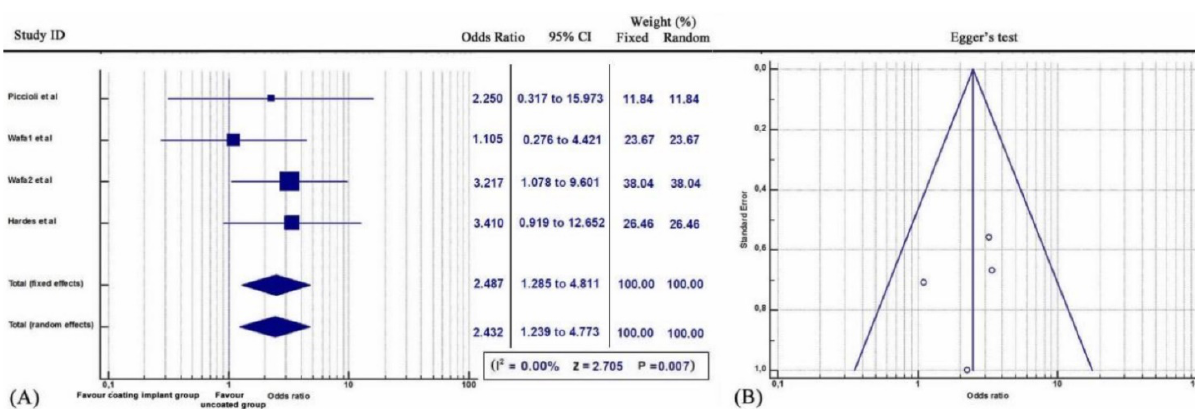
Figure 3. (A) Forest plot showing the likelihood of periprosthetic infections in the Antibiotic (DAC) coating implant group versus the group without coating implants. (B) Funnel plot of the Egger’s test was utilized to assess for publication bias.